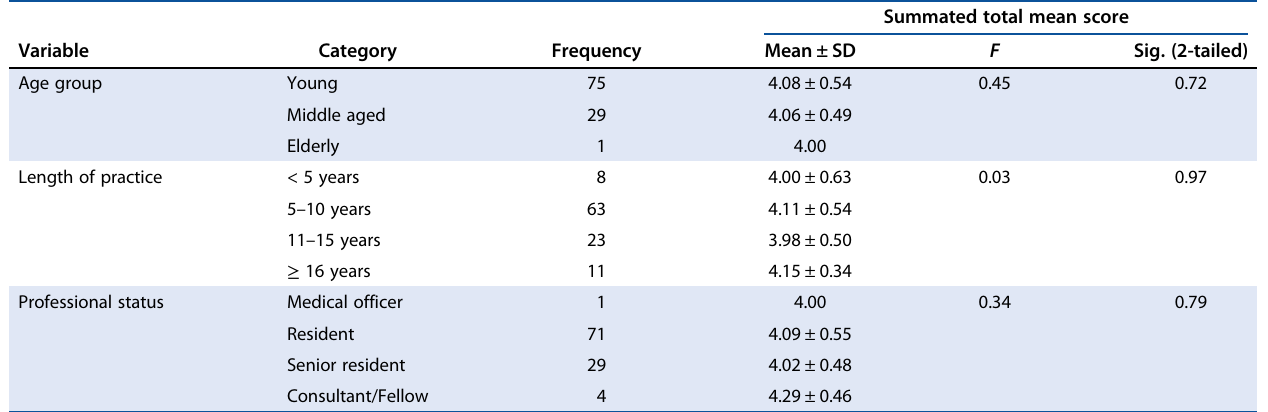
Table 5: Association between quality of respondents ’ communication of diabetes self-management and age group, length of practice and professional status